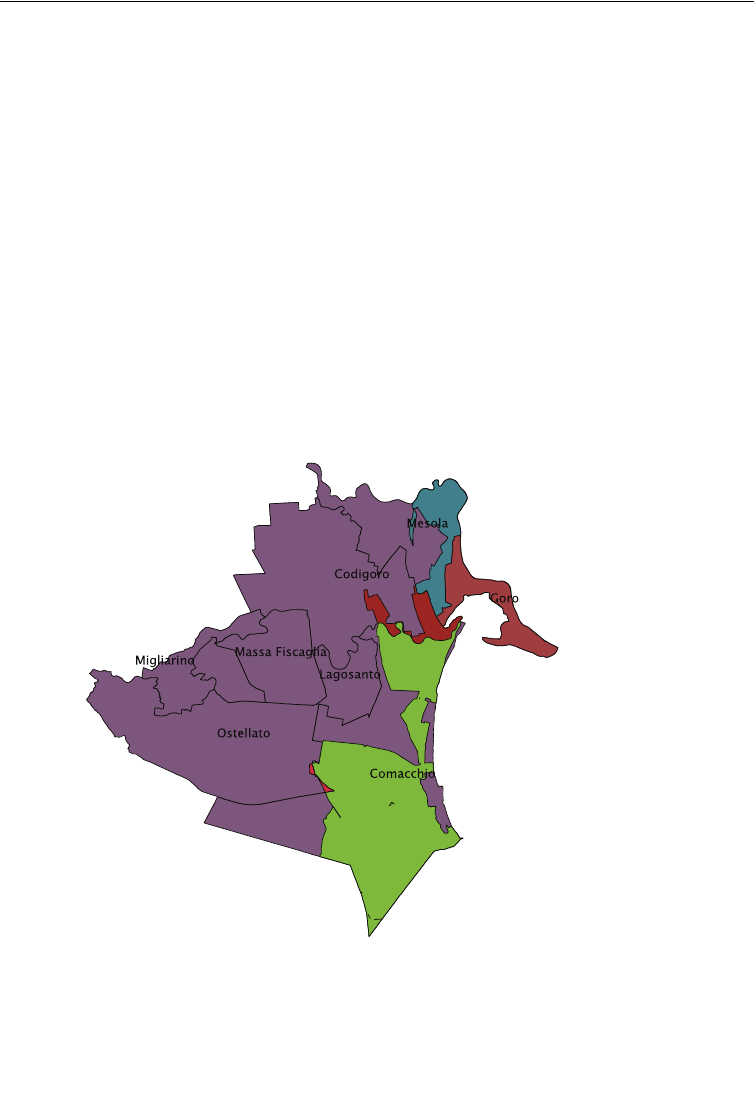
Figure 1 { Po Delta Park areas included in CLAIM project (green, red and blue zones identify different park